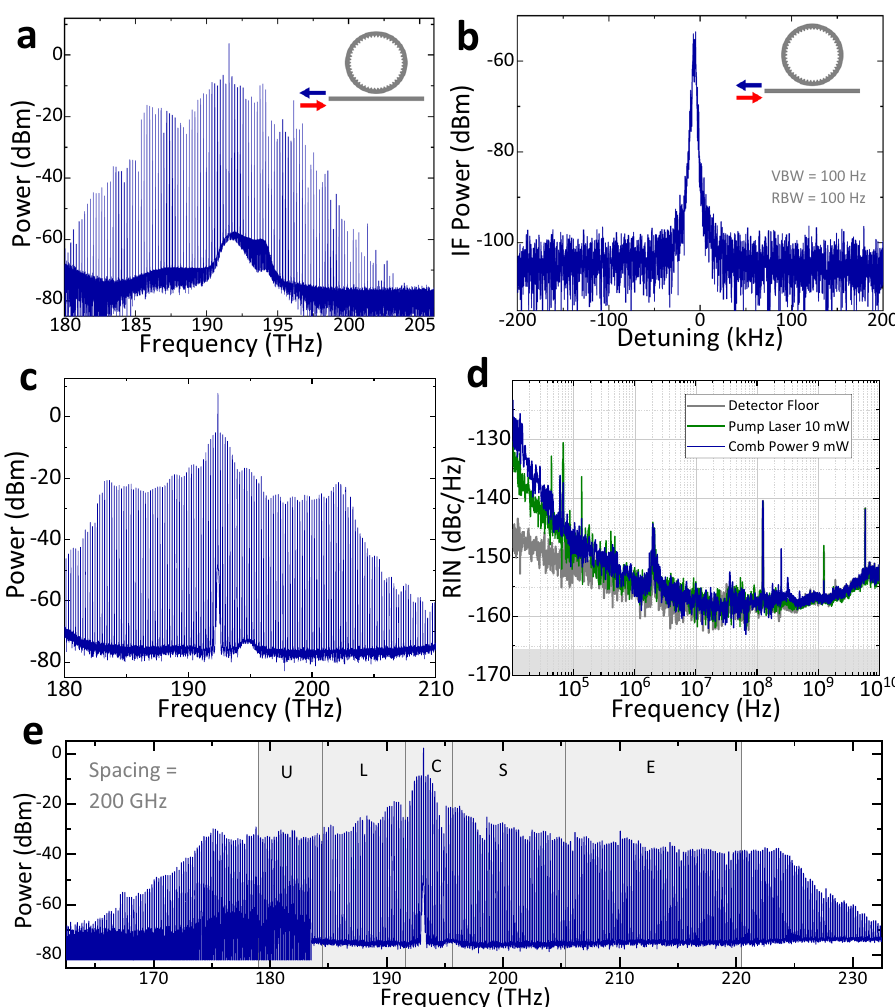
Fig. 5 Frequency comb and noise characterization. a Optical spectrum and ( b ) down-mixed electronic repetition rate beatnote measured at the re fl ection port. c Optical spectrum and ( d ) corresponding measured relative intensity noise on the comb power. e Demonstration of a 200 GHz repetition rate comb covering Telecom U through S